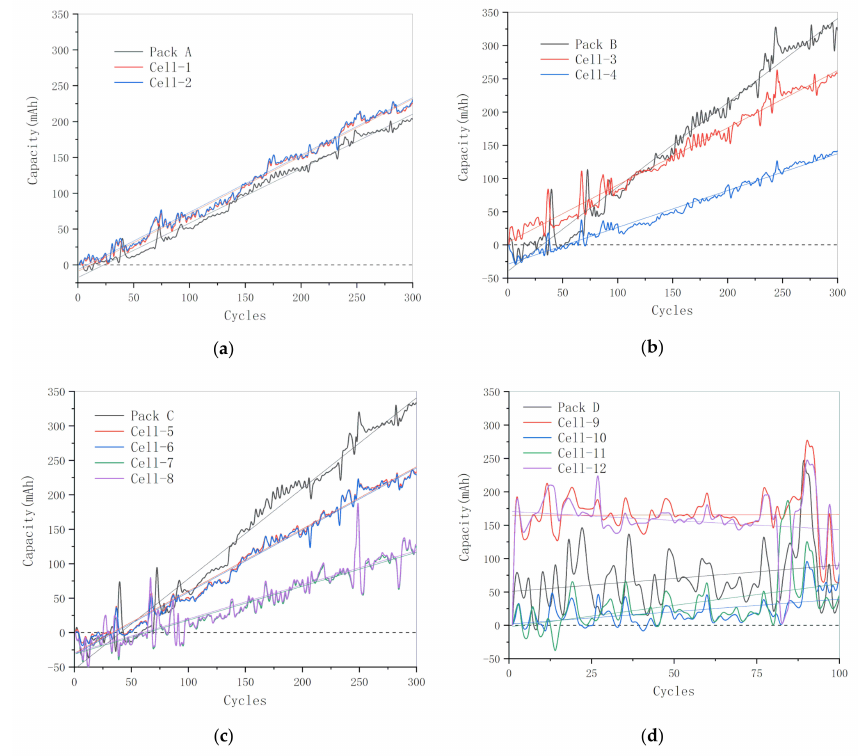
Figure 7. Battery pack discharge capacity degradation curve: ( a ) Pack A; ( b ) Pack B; ( c ) Pack C; ( d ) Pack